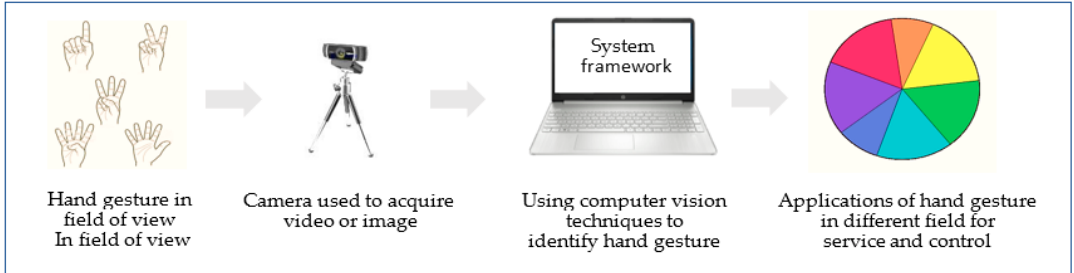
Figure 4. Using computer vision techniques to identify gestures. Where the user perform specific gesture by single or both hand in front of camera which connect with system framework that involve different possible techniques to extract feature and classify hand gesture to be able control some possible application.